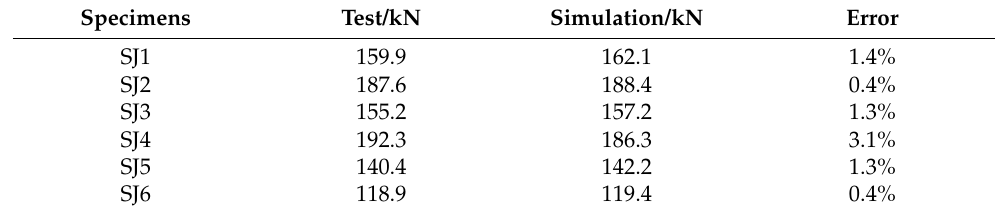
Figure 14. The comparison of hysteresis curves between the finite element simulation and the experiment: ( a ) SJ1; ( b ) SJ2; ( c ) SJ3; ( d ) SJ4; ( e ) SJ5; ( f ) SJ6. Table 5. The comparison of the average sliding friction force values between the finite element simulation and the experiment.